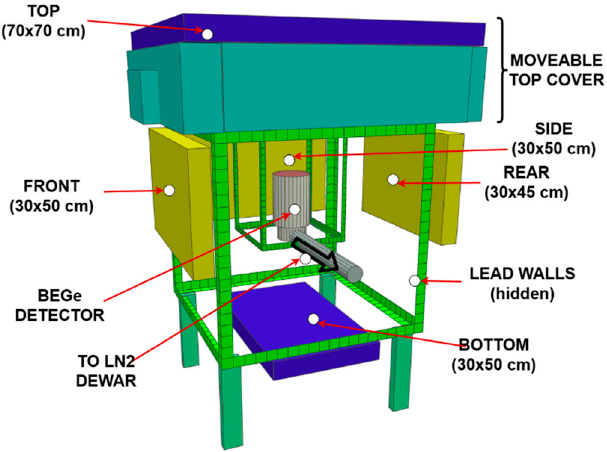
Figure 1. The relative positioning of the low-background, digital gamma-ray spectrometer’s detectors. In blue—horizontally (TOP and BOTTOM); in yellow—vertically placed scintillators (FRONT, SIDE and REAR). Each of the scintillators is 5 cm thick. The device is in operation at the Institute of Nuclear Physics Polish Academy of Sciences. Some parts of the passive shield (e.g., the lead walls) are